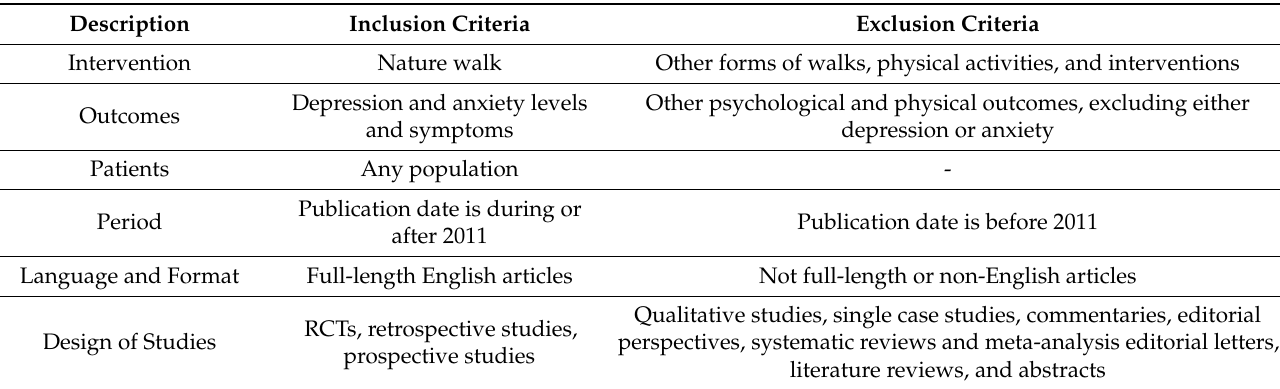
Table 1. Inclusion and exclusion